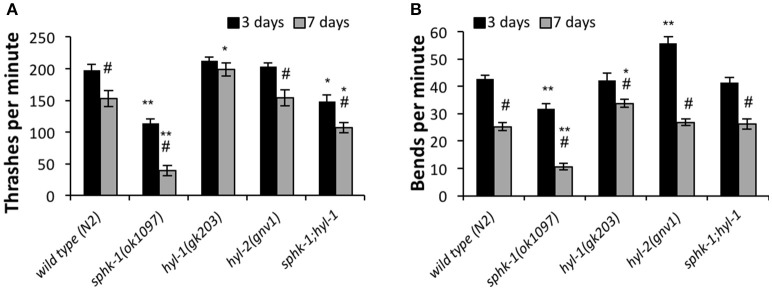
Sphingolipid enzymes regulate locomotor behavior. The number of thrashes per minute (A) and body bends per minute (B) for wild type and the indicated mutants, analyzed at 3 and 7 days (n = 25 for all groups). For all experiments, animals were examined 3 or 7 days post-hatching, and were transferred onto normal NGM plates for testing. For all, error bars are ± SEM; *p < 0.01 and **p < 0.001 for comparisons to the wild type counterpart, and #p < 0.01 for comparisons to the 3 day old counterpart.